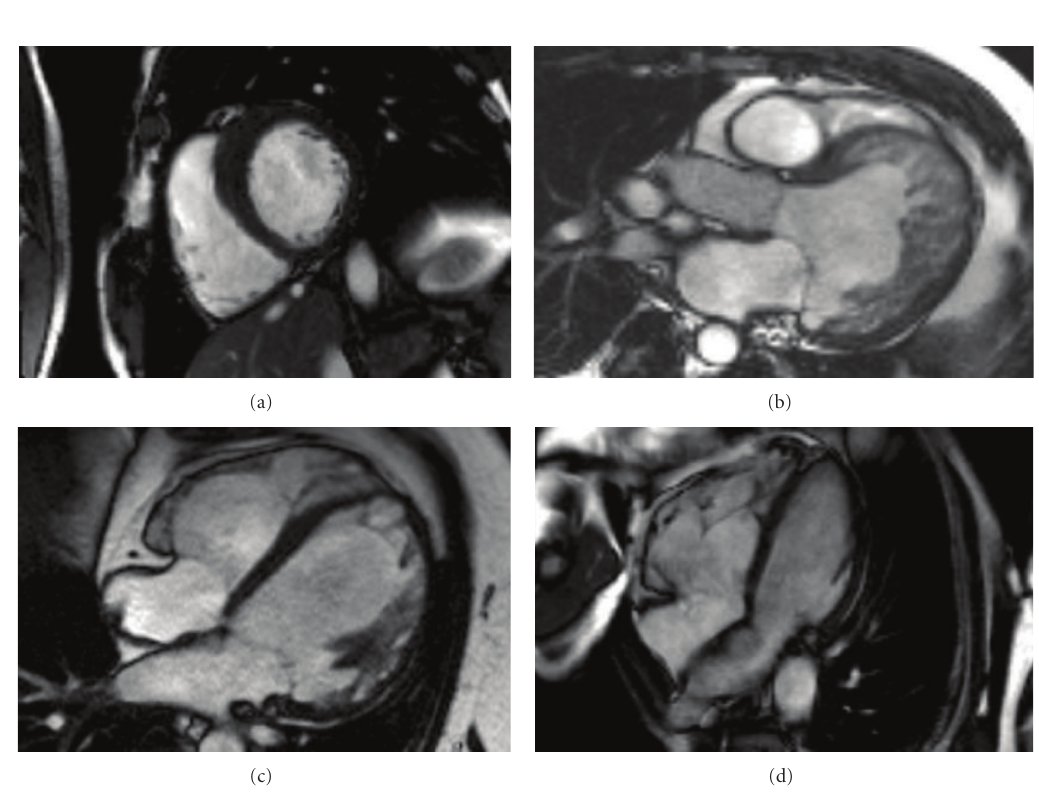
Figure 3: CMR cine sequences demonstrating the di ff ering morphologies of inherited cardiomyopathies. (a) HCM: asymmetric basal anterospetal wall hypertrophy; (b) LVNC: left ventricular hypertrabeculation and dilatation; (c) FDCM: left ventricular wall thinning and dilatation; (d) ARVC: right ventricular